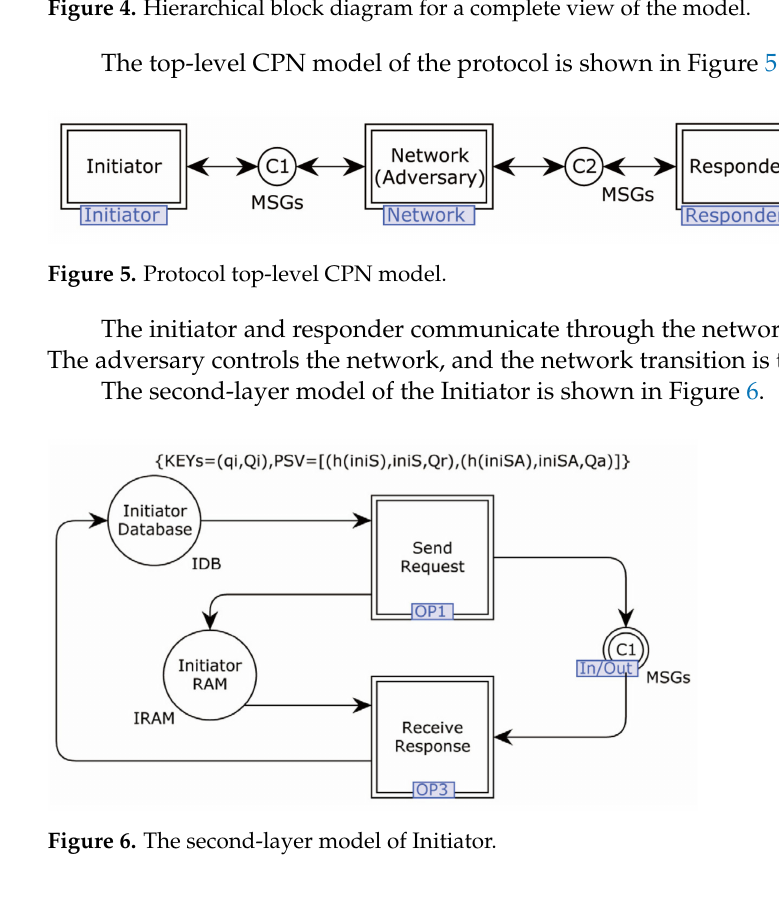
Figure 4. Hierarchical block diagram for a complete view of the model.